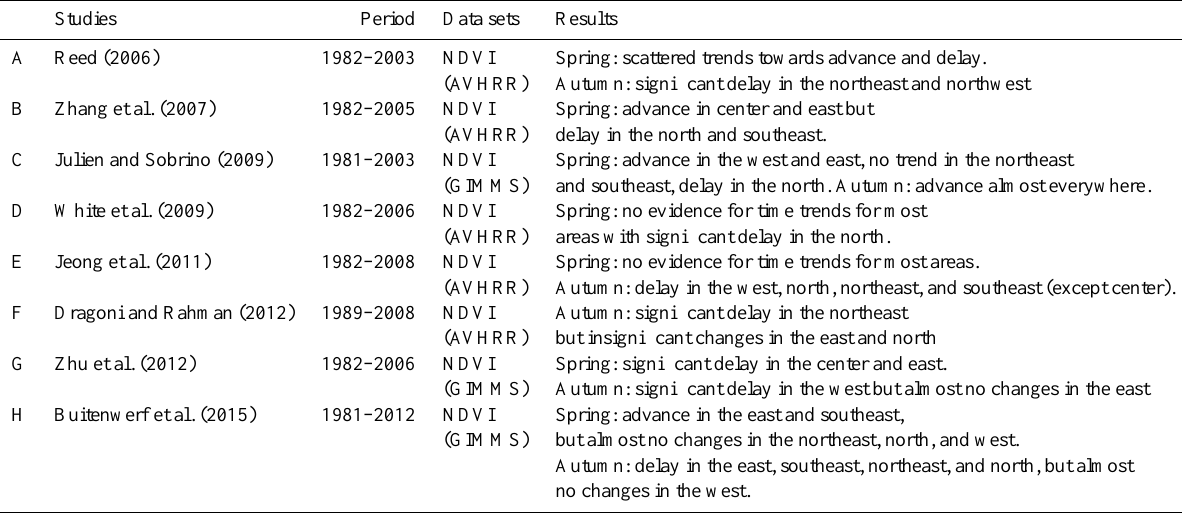
Table 1. Summary of studies estimating phenology trend in the USA for at least 20 years.